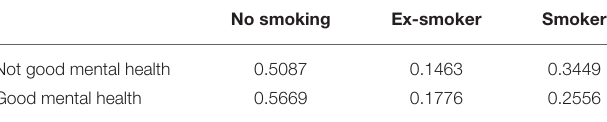
TABLE 4 | Predicted probabilities for each alternative by mental health.